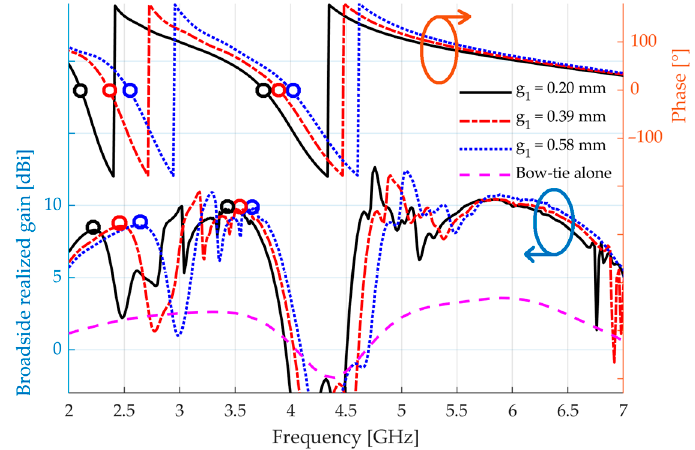
Figure 14. Broadside realized gain of the final structure when g 1 is varied. The phase difference ϕ t between the direct and reflected electric fields over the unit cell, considering h = 10 mm, is also shown. Dots indicate each ϕ t = 0 ◦ and their respective gain peaks. Their frequencies do not coincide, but their relative shifts, when g 1 varies, do.